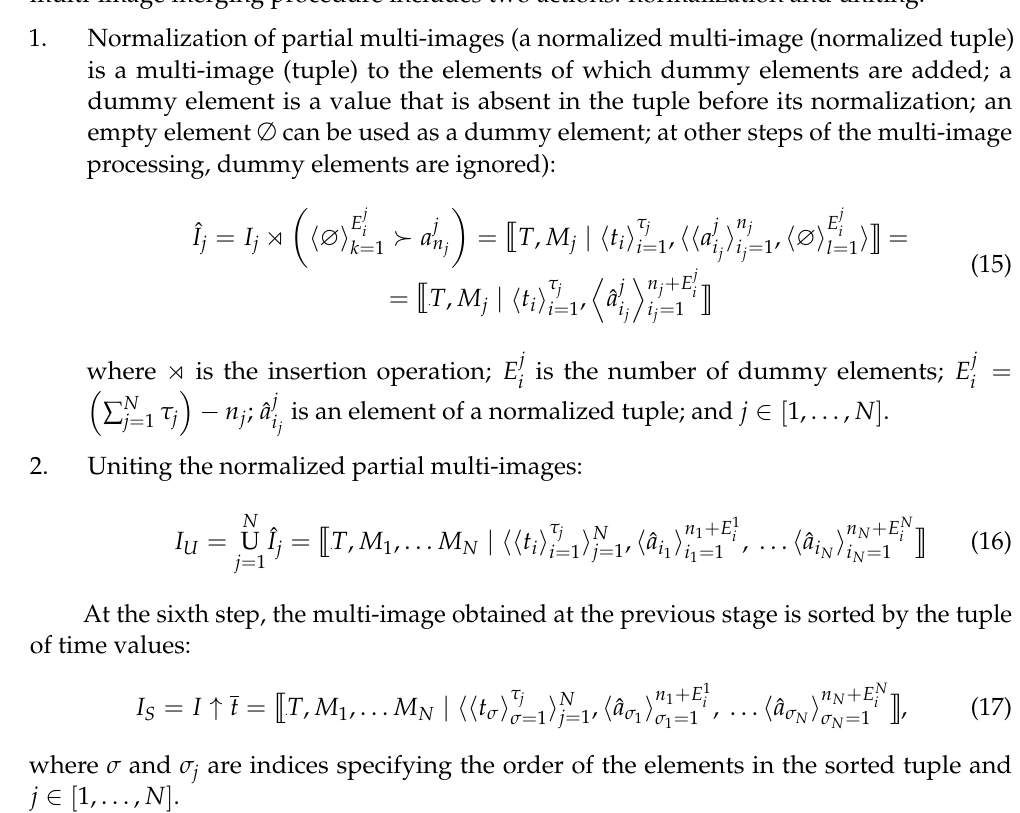
Figure 1. An example of two compatible aggregates.